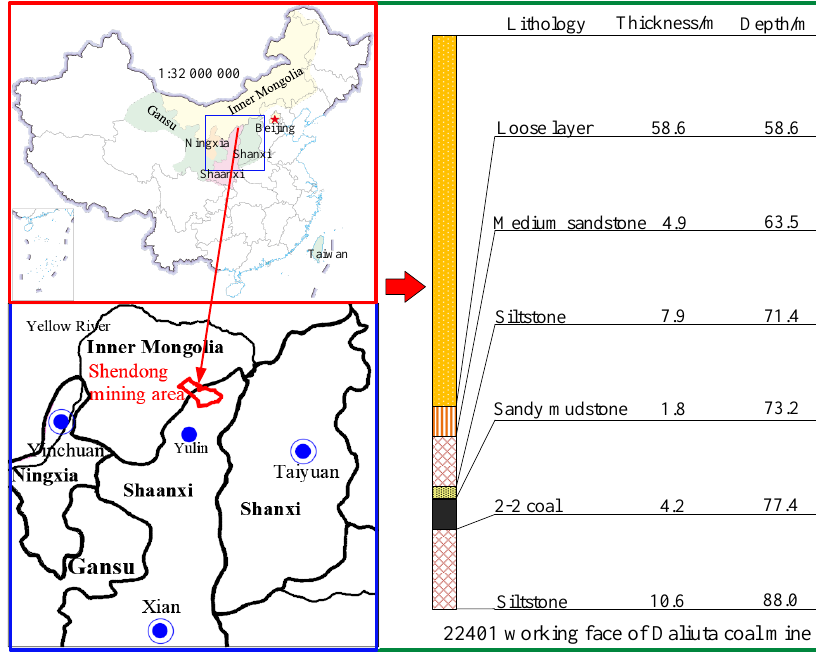
Figure 4. Rock lithology and thickness of the working face.